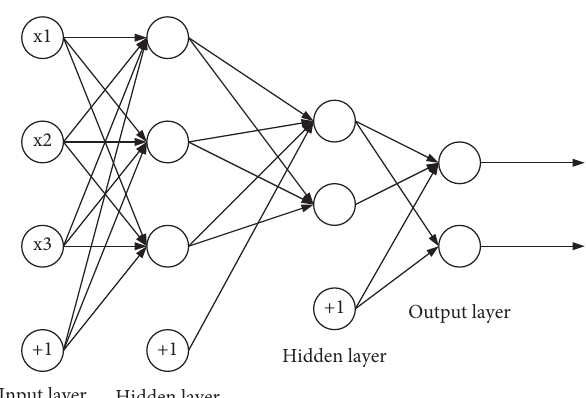
Figure 3: Multi-hidden neural network structure.